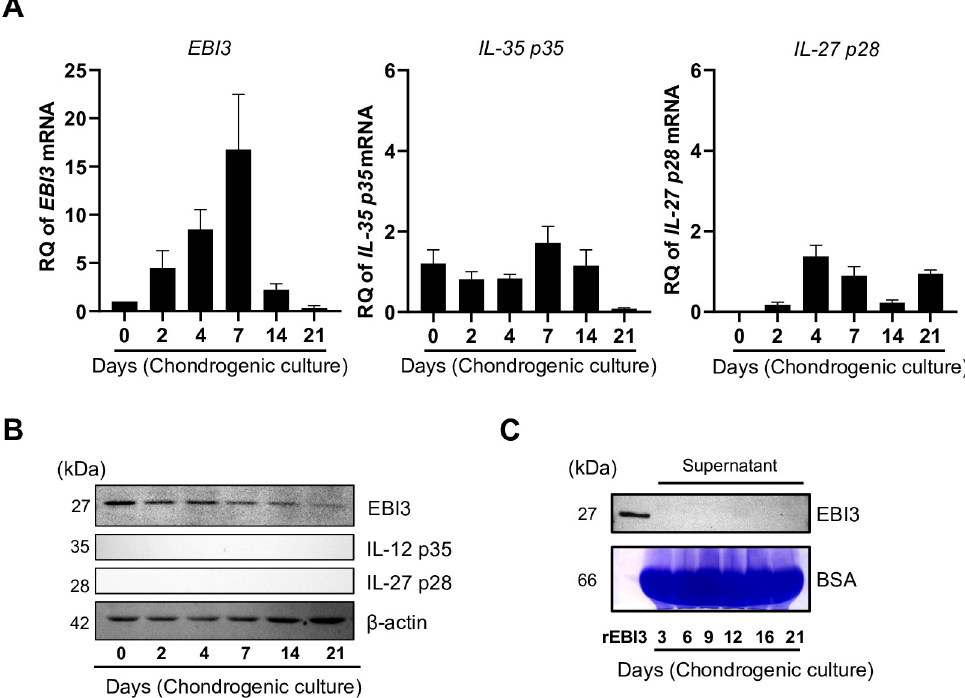
Fig 1. MSCs produce EBI3 in cells during chondrogenic differentiation. (A-C) Human MSCs were cultured as aggregates in chondrogenic medium. (A) EBI3 , IL-35 p35 and IL-27 p28 mRNA levels were evaluated by RT-qPCR at the indicated time points. All quantitative data are expressed as the mean ± SD (each n = 3). (B) EBI3, IL-35 p35, and IL-27 p28 protein levels in chondrogenic MSCs were detected at the indicated time points by Western blotting. β -actin was used as a loading control. Results are representative of 3 independent experiments with similar findings. (C) EBI3 protein levels in culture supernatants during chondrogenesis were detected by Western blotting. BSA was detected by CBB staining and used as loading control. Results are representative of 3 independent experiments with similar